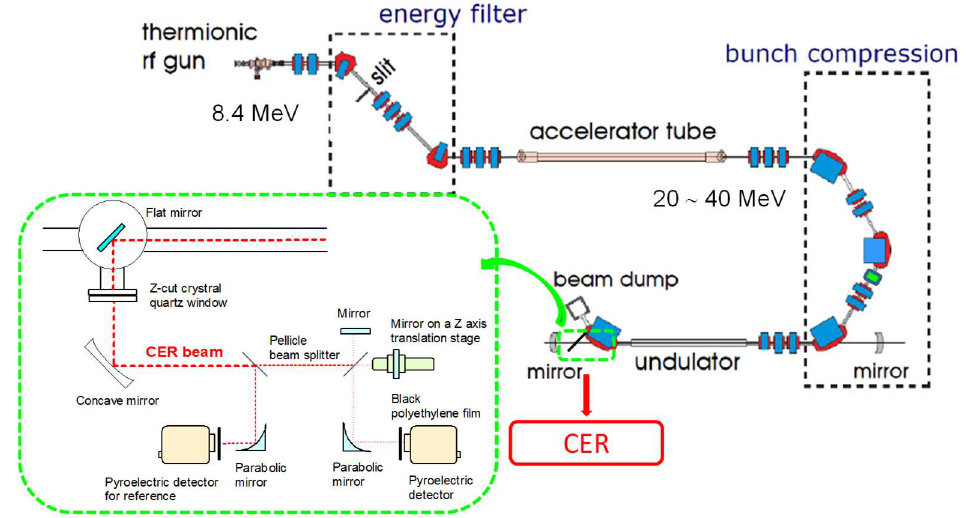
Figure 1. Schematic outline of KU-FEL and observation system for the CER beam.